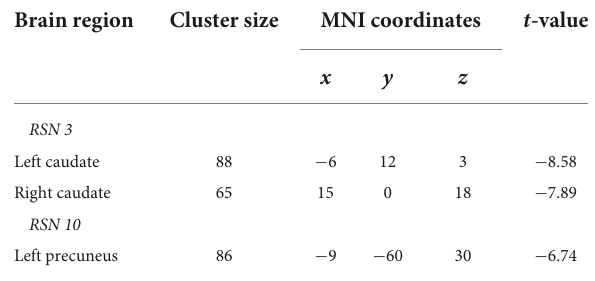
TABLE 2 The intranetwork difference in identified RSNs between FCon patients and healthy